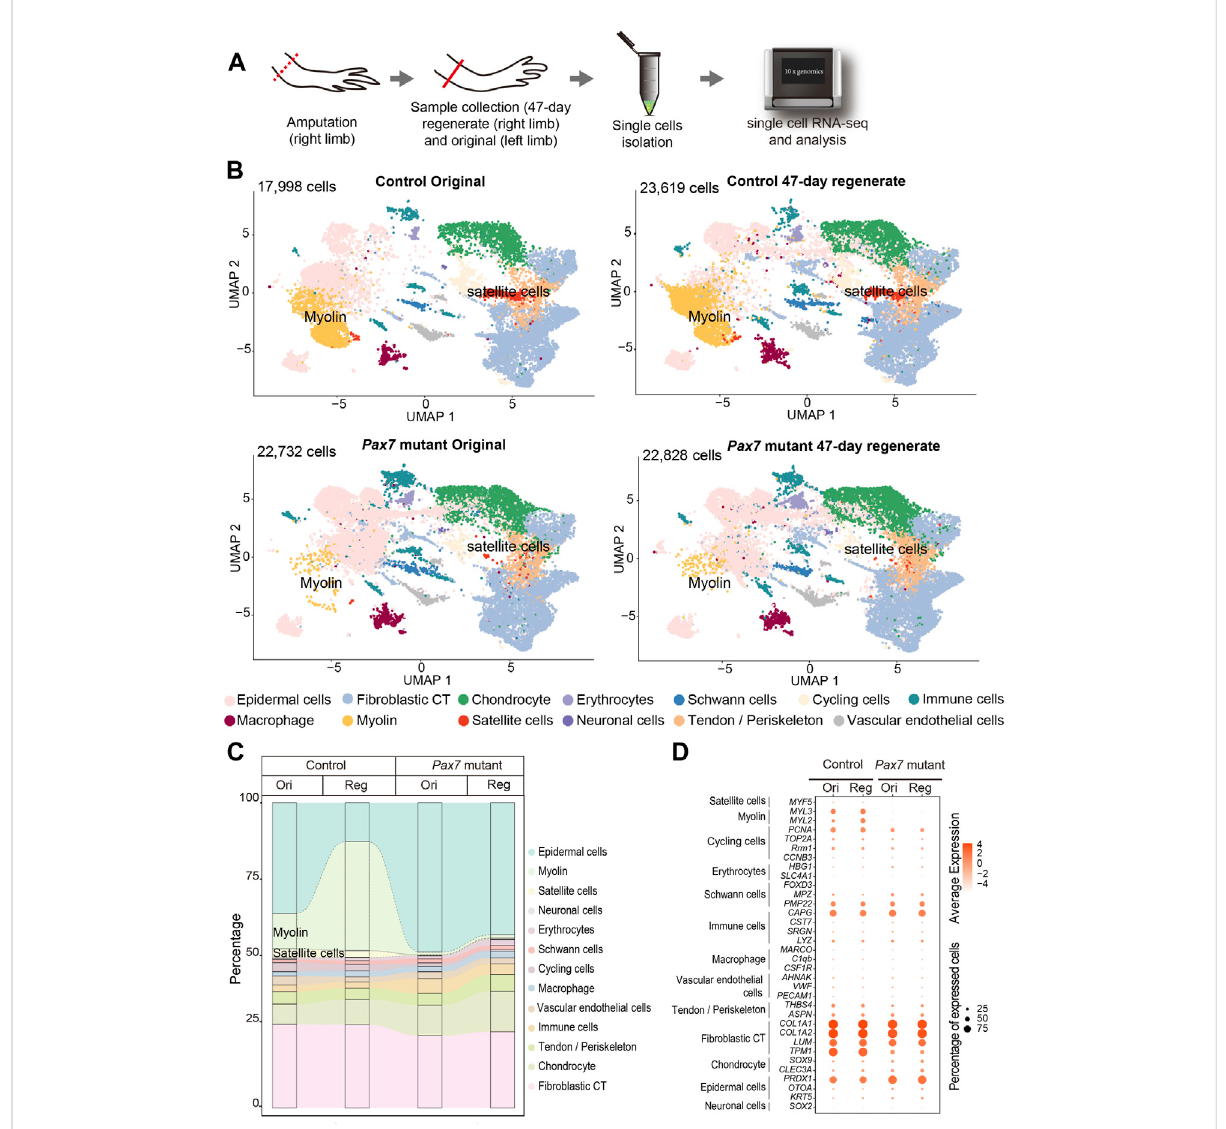
FIGURE 4 Integrated transcriptional cell state atlas of the axolotl limb from the 47-day regenerate and original in both controls and Pax7 mutants. (A) SchemeofthescRNA-seqwork fl owusedforthelimbtissuescollectedfromthe47-dayregenerate(rightlimb)andoriginal(leftlimb)inbothcontrols and Pax7 mutants. Dotted line, amputation plane; line, the position of sample collection. (B) UMAP visualization of the scRNA-seq data from four sampling stages. The cell-type annotation is determined by published cell-lineage speci fi c markers. Two muscle-related cell types are highlighted. (C) Sankey plot showing the percentage of all 13 cell types from the 47-day regenerate and original limbs in both controls and Pax7 mutants. (D) Dot plot visualizing the expression of marker genes of all 13 cell types shared between the controls and Pax7 mutants. The circle size represents the percentage of cells at each sample expressing the gene, and color represents the average expression